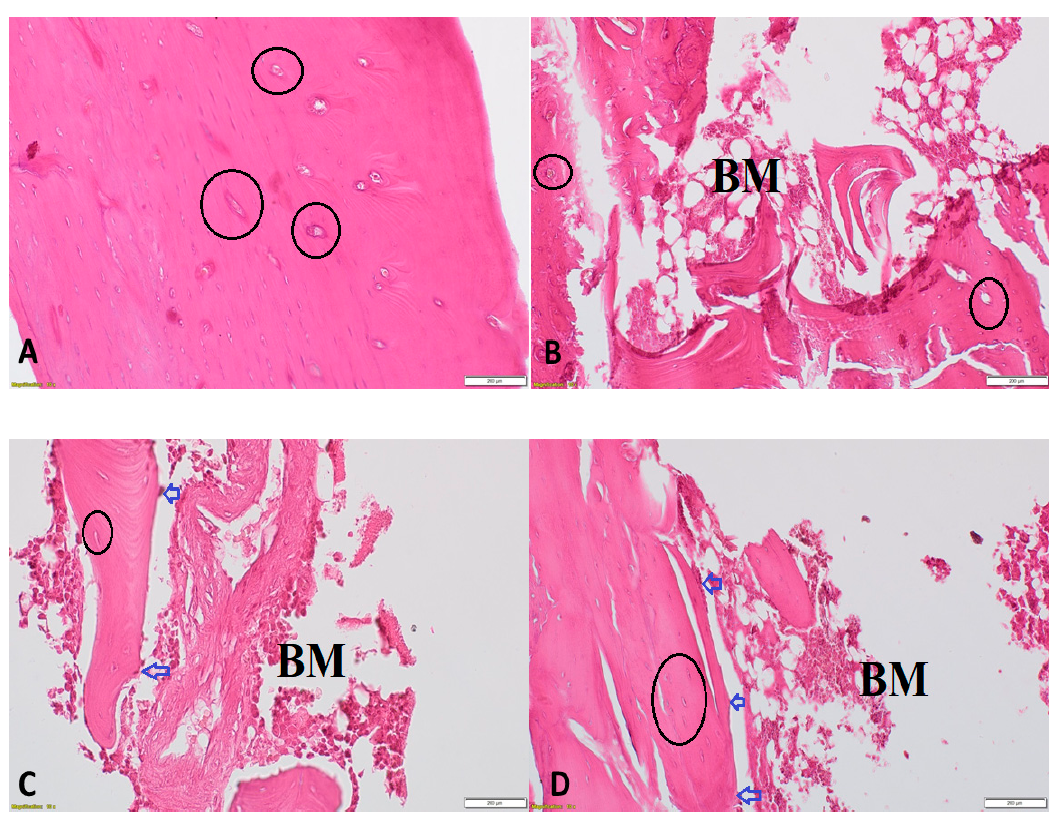
Figure 6. Histopathological examination using H&E of proximal metaphysis of the tibia from di ff erent groups. The specimens from control group showing a network of trabeculae of cancellous bone with osteocytes within their lacunae within bone trabeculae (black circles) (200 × ) ( A ), from ORCH group showing loss of trabecular bone with bone marrow spaces (BM) and few osteoblasts (blue arrows) appear rimming the endosteal surface and (200 × ) ( B , C ) and from DHEA + ORCH group showing normal trabecular bone architecture with osteoblasts at endosteal surface (200 × ) ( D